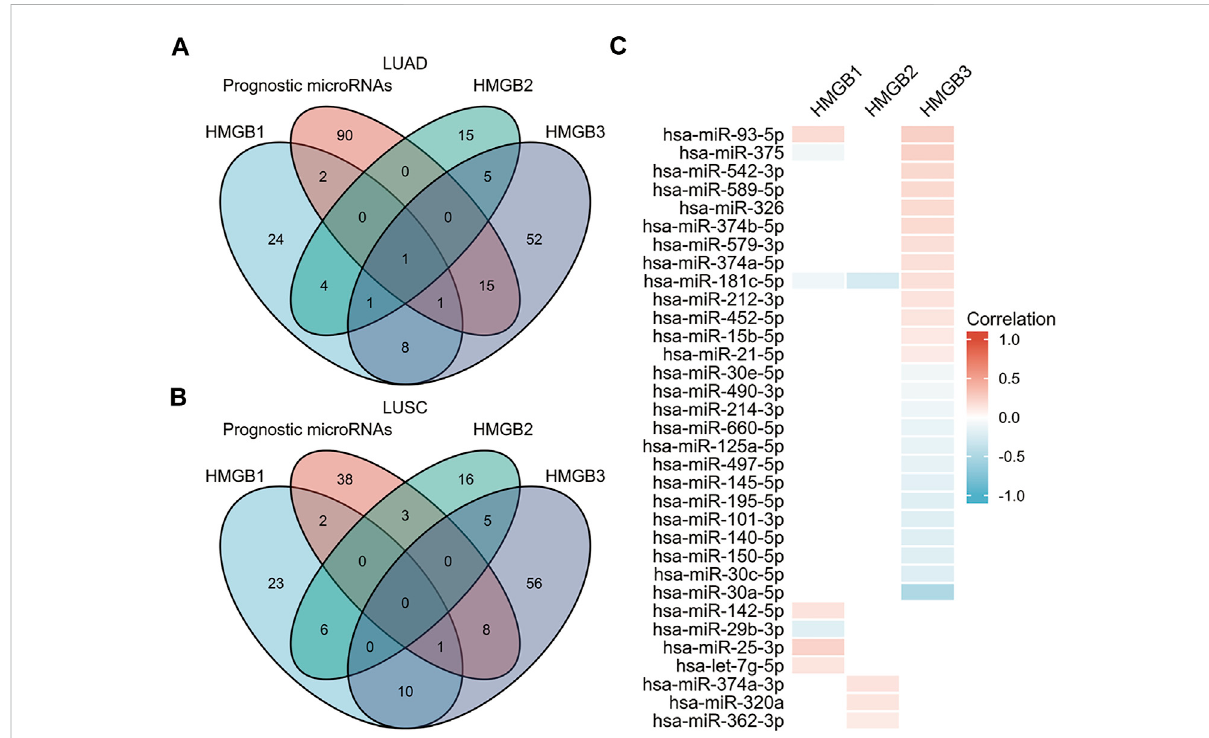
FIGURE 7 Identi fi cation of microRNAs of prognostic value in NSCLC and their predicted interactions with HMGB family member genes. (A) Venn diagram depicting the intersection of HMGB-targeting microRNAs in LUAD from the starBase and OncomiR databases. (B) Venn diagram depicting the intersection of HMGB-targeting microRNAs in LUSC from the starBase and OncomiR databases. (C) Correlation of HMGB family members expression and expression of microRNAs that have prognostic value in